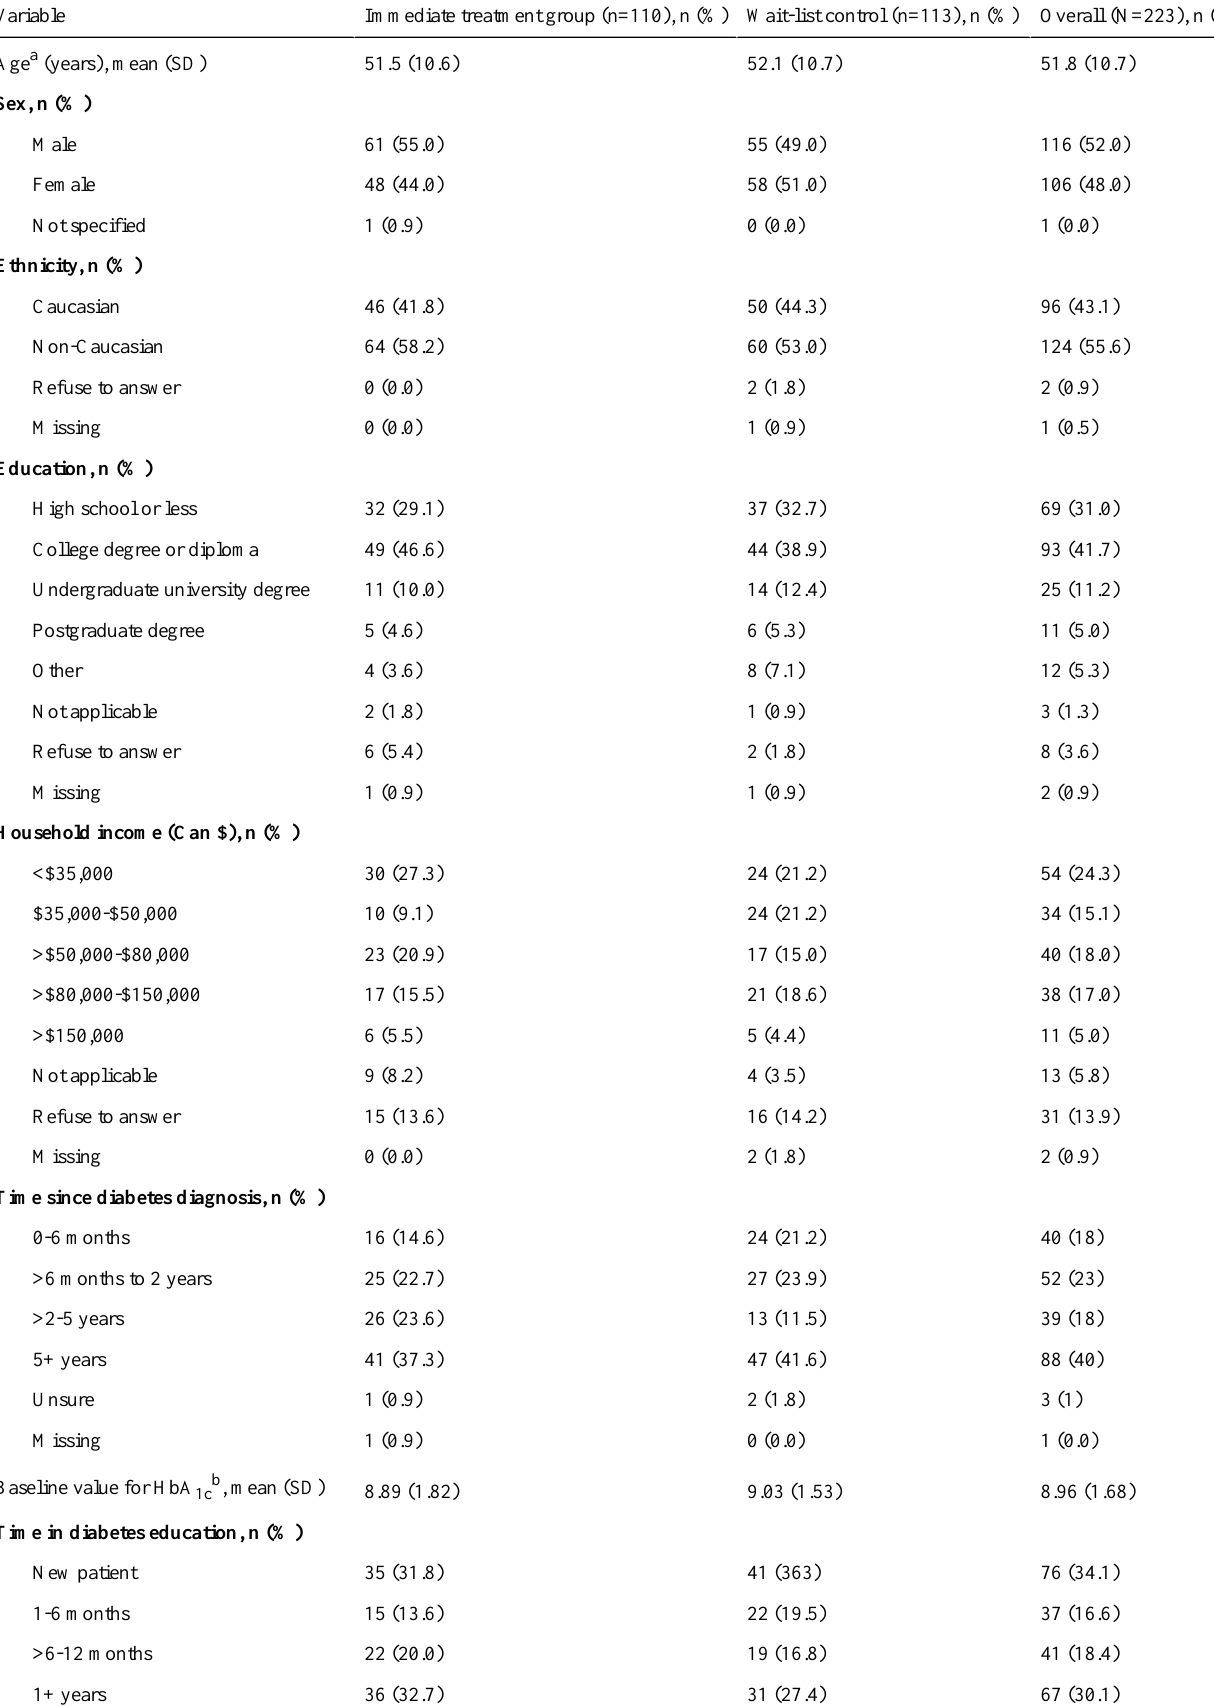
Table 1. Baseline characteristics of